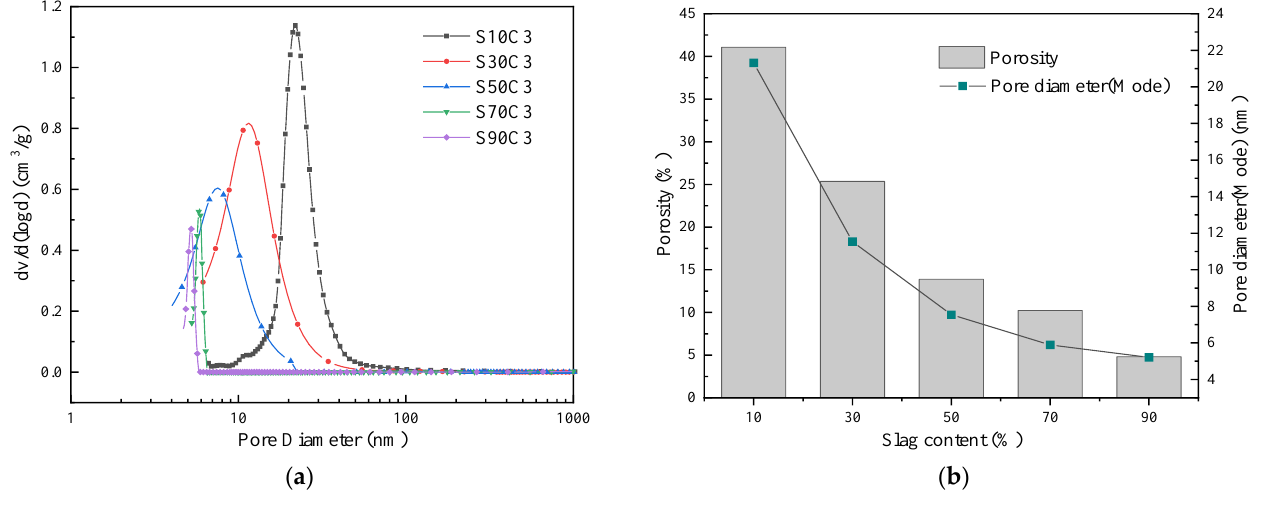
Figure 7. Results of the MIP analysis of alkali-activated composite cementitious materials under different slag contents: ( a ) pore size distribution; ( b ) porosity and the pore diameter (mode).